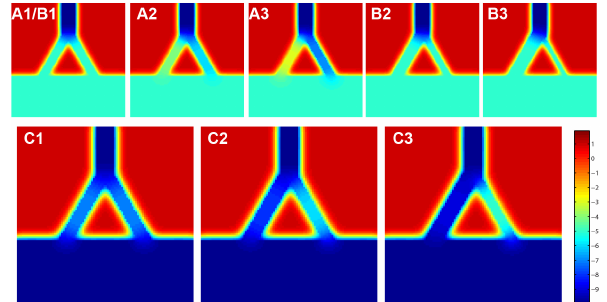
Figure 7. Channel geometries for test 3 (single bifurcation test). Group A (A1, A2 and A3) and group B (B1, B2 and B3) have a smaller domain and input discharge. Within group A the ratio of depth between the two downstream branches is varied while keep- ing width constant. Within group B the ratio of width between the two downstream branches is varied while keeping depth constant. Within group C (C1, C2 and C3) width and depth are varied in the same proportion while keeping the summation of cross-sectional area